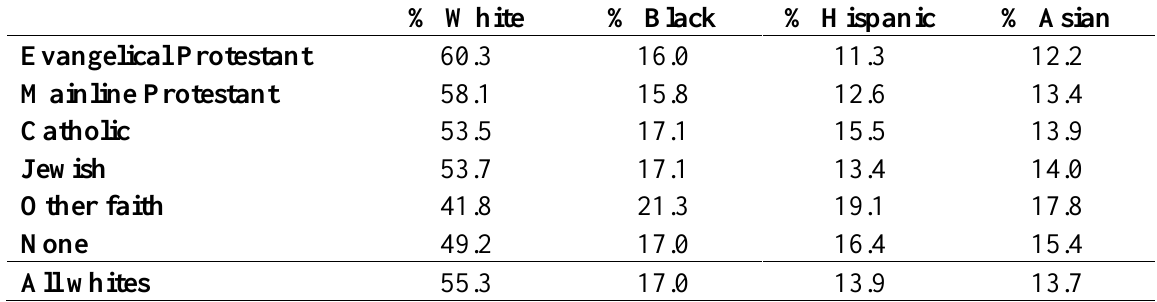
Table 4. Neighborhood Racial Preferences among Non-Hispanic Whites, by Religious Tradition.